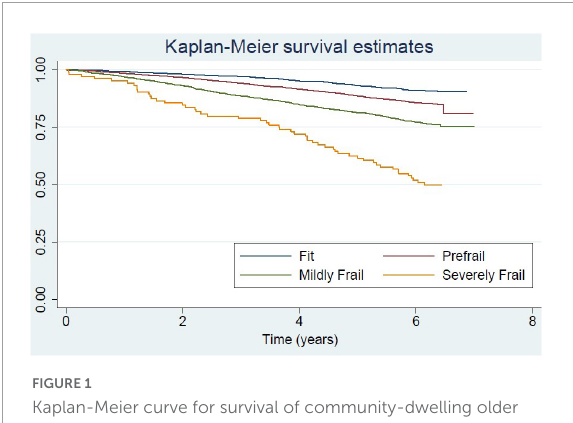
FIGURE1 Kaplan-Meier curve for survival of community-dwelling older adults in National Health Examination Survey (NHES-IV) comparing among frailty status.